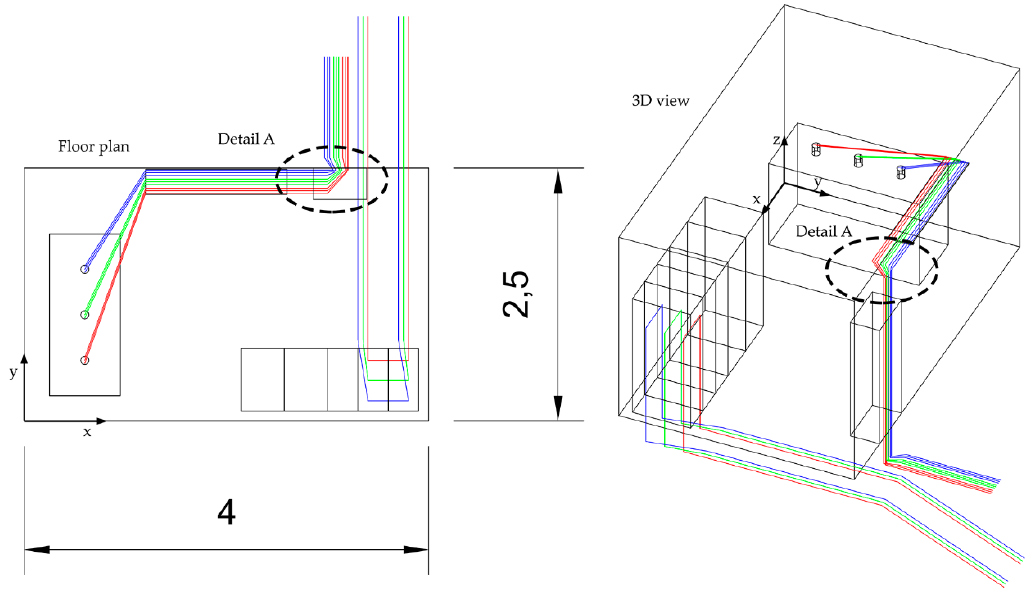
Figure 10. Floor plan (left) and 3D view (right) of the DTS to study with the existing cable routing (dimensions in meters). Detail A is shown in Figure 11.